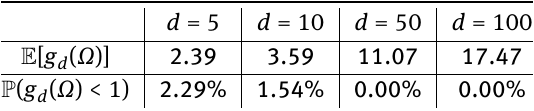
Table 1: Mean of the probability distribution of g d ( Ω ) and probability that no subset of leaves is overweighted in the MVP, with Ω ∼ U ( C d ) based on n = 1, 000, 000 simulations, for d ∈ { 5, 10, 50, 100 } .